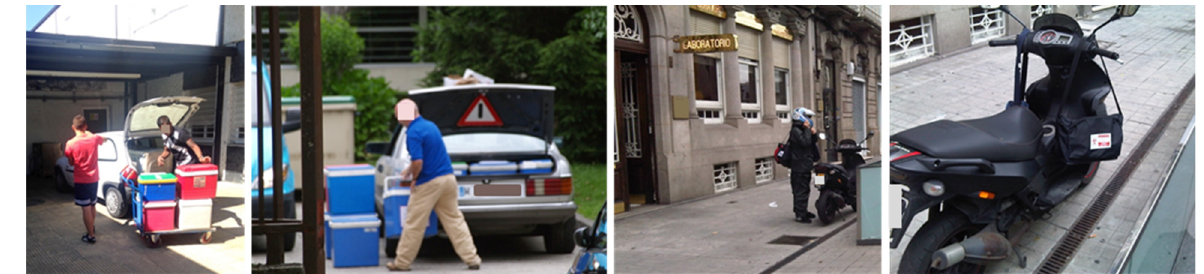
Figure 6. Poor practices in the transport of infectious samples.